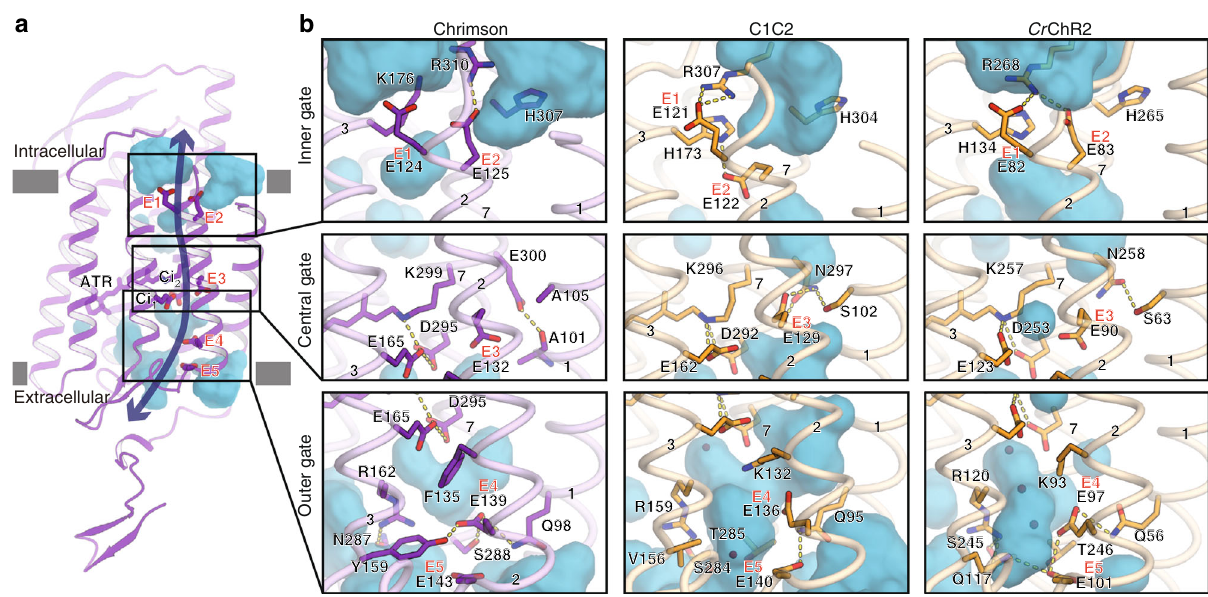
Fig. 2 Ion pores of Chrimson and ChRs. a Water accessible cavities are illustrated in the Chrimson structure, with the putative ion pathway indicated by an arrow. Five glutamic acid residues lining the ion pore (E1 – 5) and two counterion residues (Ci 1 and Ci 2 ) are indicated by sticks, and the three constriction sites for the inner, central and outer gates are indicated by boxes. b Comparison of the constriction sites of Chrimson (left panels), C1C2 (center panels), and Cr ChR2 (right panels), for the inner (upper panels), central (middle panels), and outer (lower panels) gates. The constituent residues are shown as sticks, and the TM helix number is indicated on each